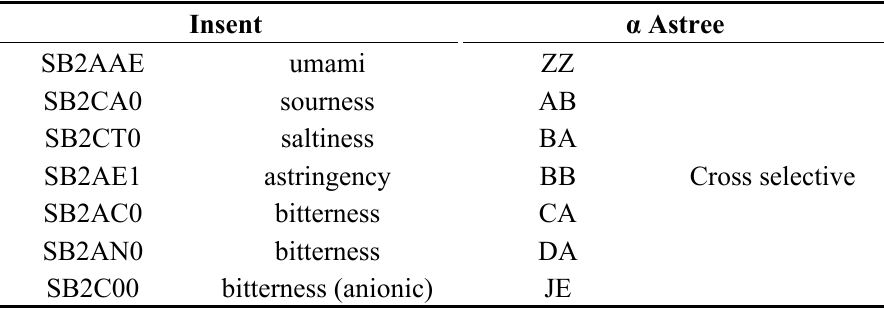
Table 4. Sensors of the electronic taste sensing